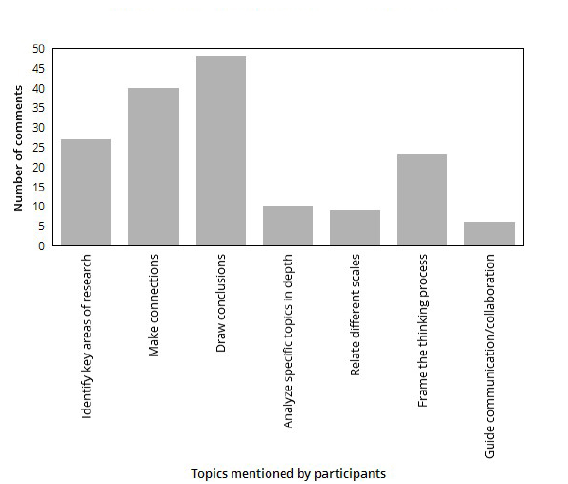
Figure 13. EIMS contribution in relation to the research and design processes